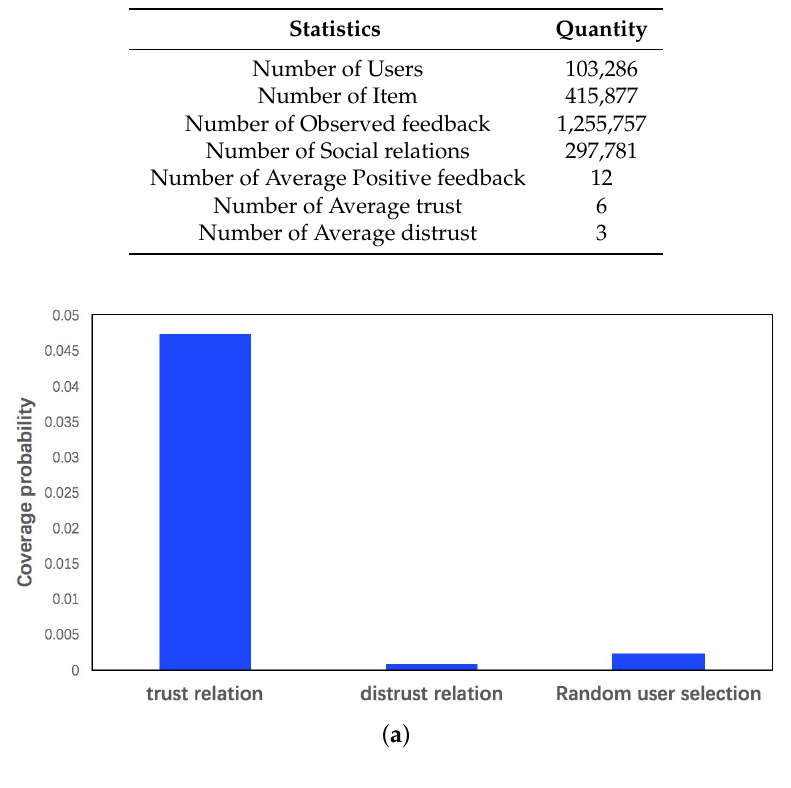
Table 1. Statistics of the Epinions